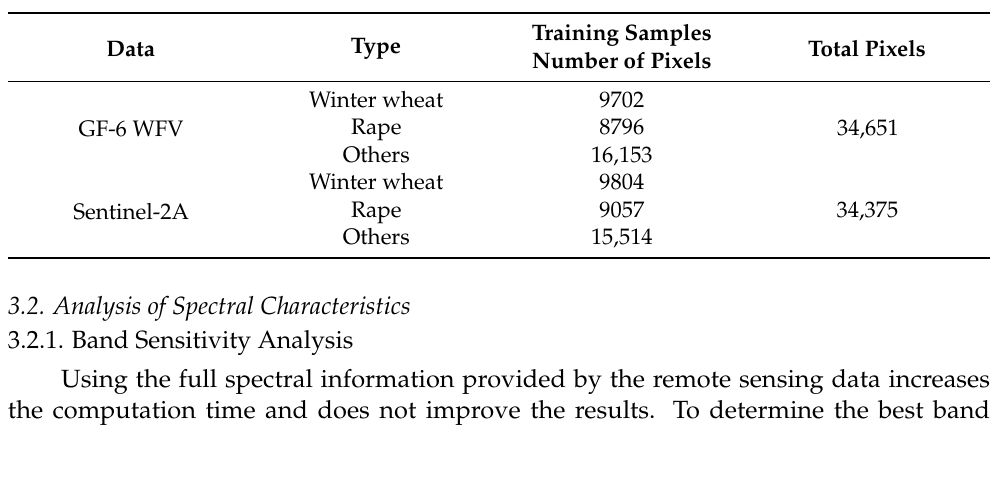
Table 5. Number of samples for different classes.